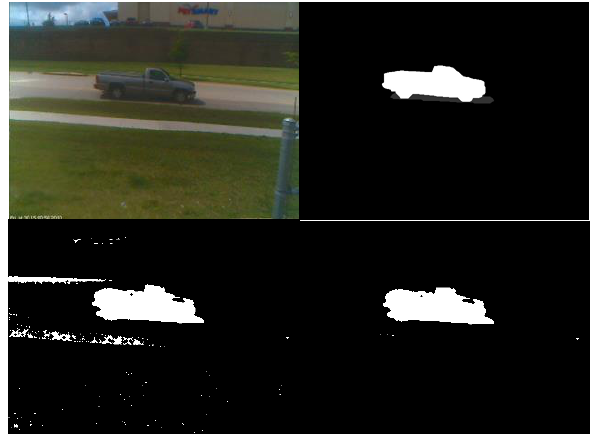
Figure 4. Experimental results for video Bank. Top row: left – current frame, right – ground truth. Bottom row: left – original algorithm, right – our modified algorithm